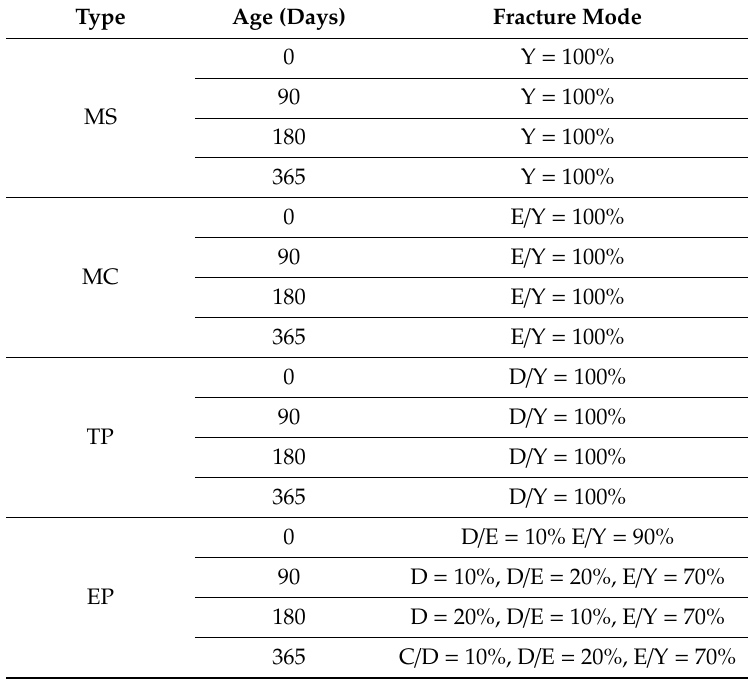
Table 6. Adhesion test results of coating systems exposed to underwater